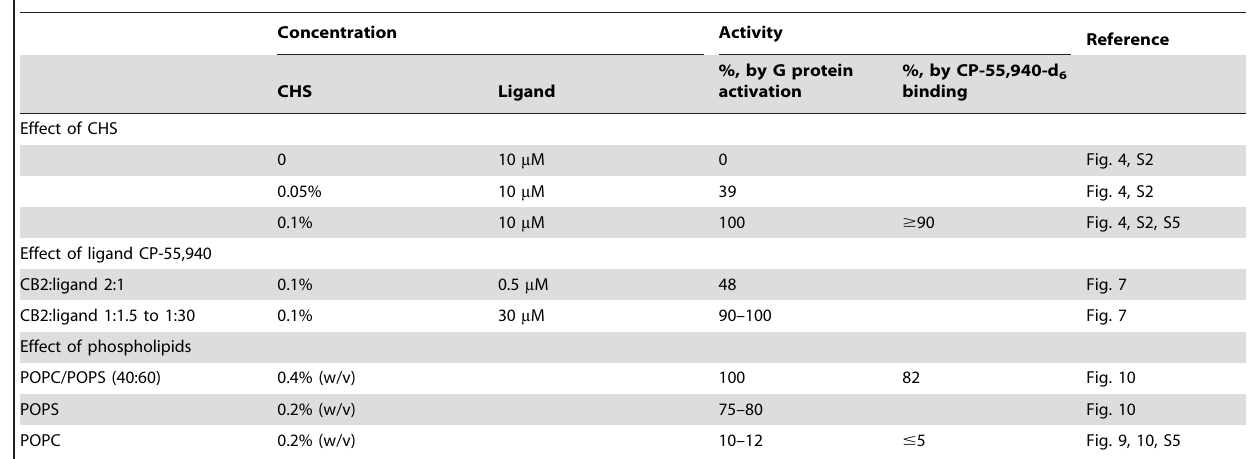
Table 3. Stabilization of CB 2 in DDM/CHAPS micelles.